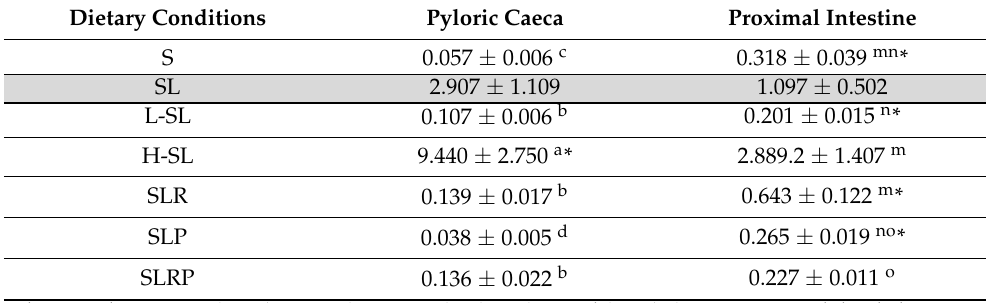
Table 4. Lipid peroxidation levels (nMols MDA × mg prot − 1 ) in pyloric caeca and proximal